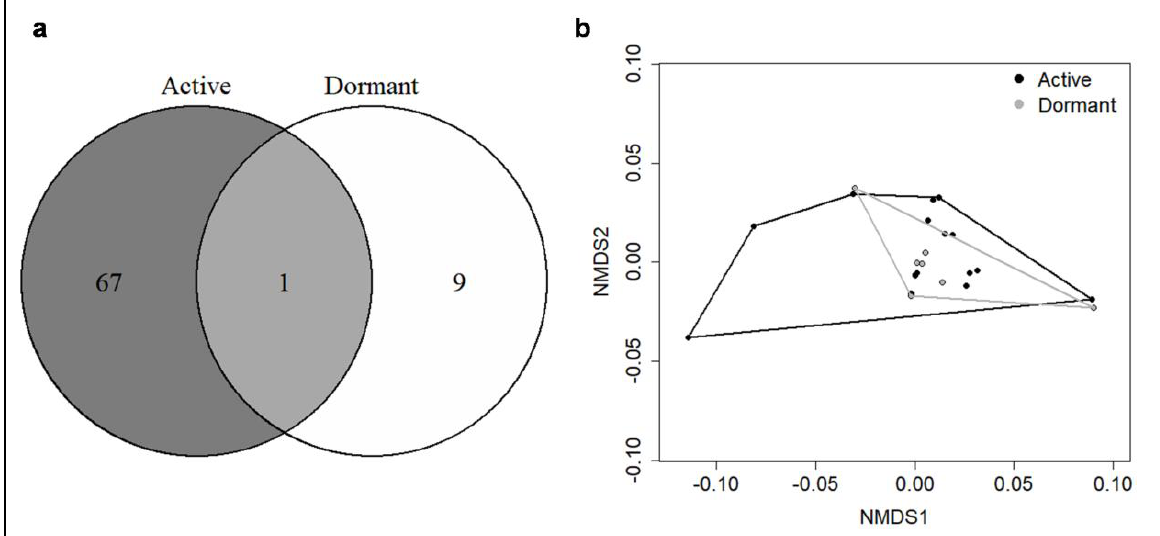
Figure 5. Distribution of the number of studies and species composition of the active and dormant forms of microcrustaceans: (a) Venn diagram with the number of studies showing the active (dark gray), dormant (white), and the two (light gray) forms of microcrustaceans in the rice fields and (b) NMDS with the composition of species of the active (black) and dormant (gray) forms of